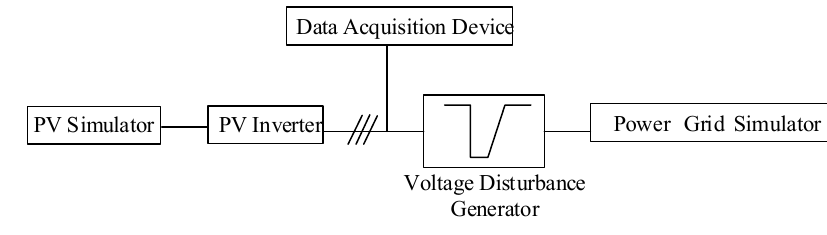
Figure 6. Diagram of test platform. Table 2. Parameters of photovoltaic inverters to be measured.